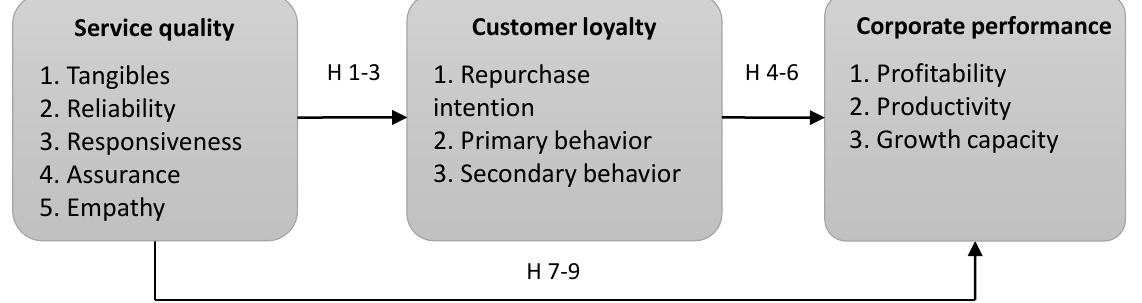
Figure 1. Research